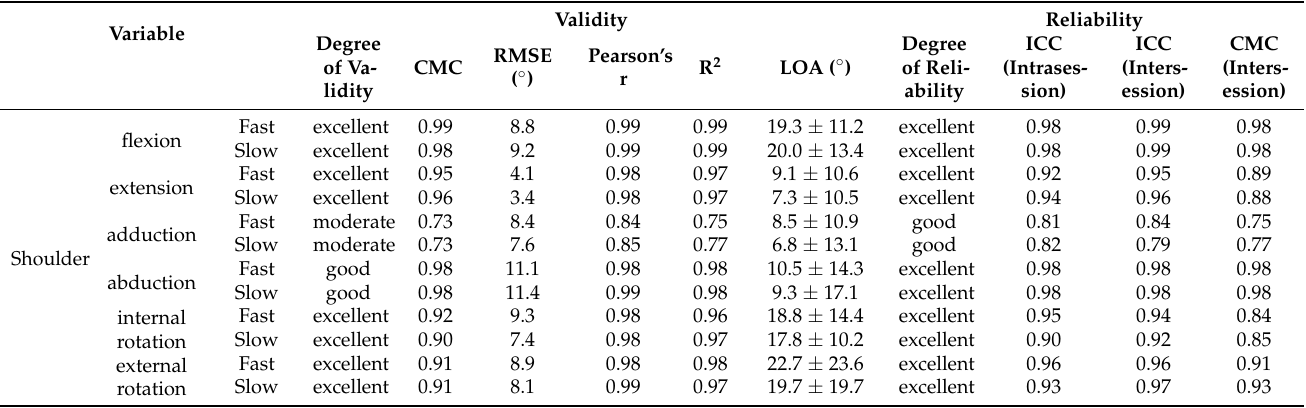
Table 1. The statistical metrics of validity and reliability of the PNS in simple tasks.